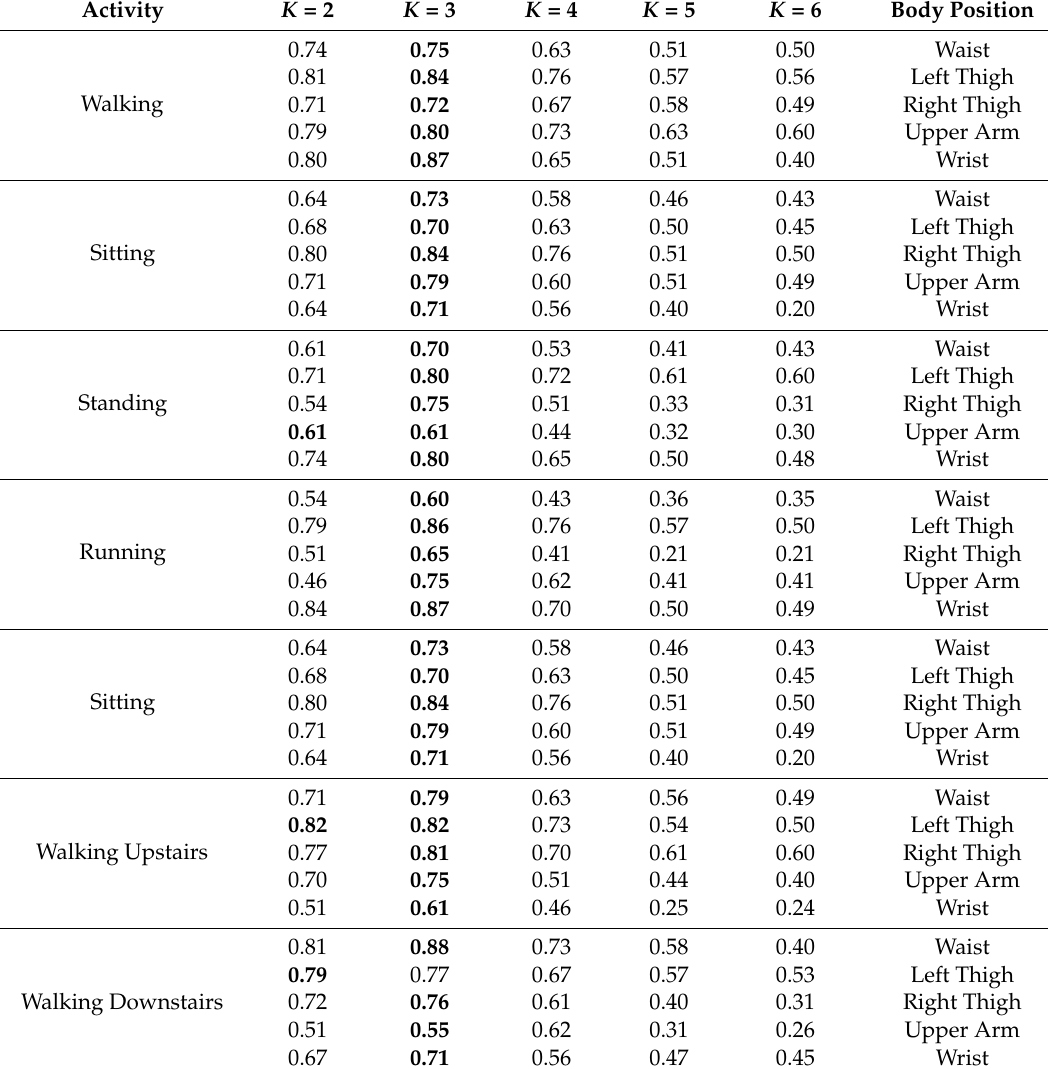
Table 4. Cluster analysis based on the average silhouette values for different values of K